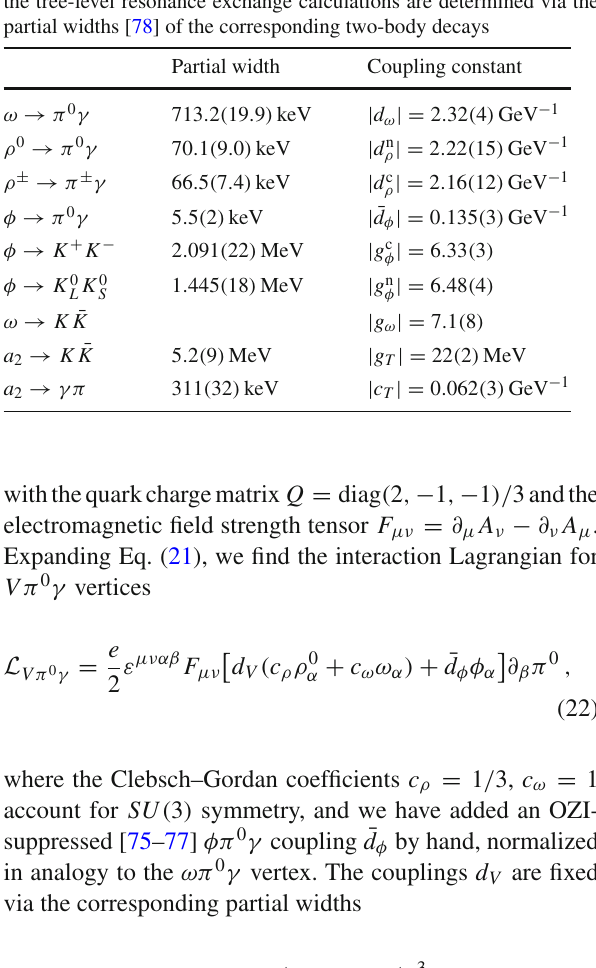
the single-variable amplitudes are denoted by η C and η G . The ‘ / ’ sym- bol indicates a non-definite value. In the last column the resonances that dominate the respective SVAs are given